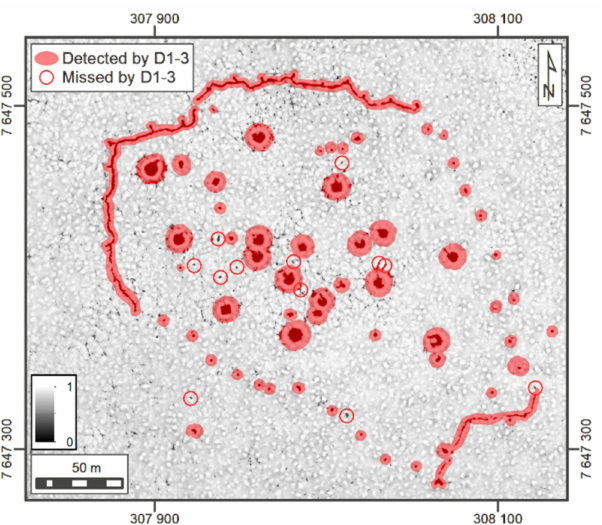
Figure 8. The feature detection results from the CNN detectors D1–3 (highlighted in red) and twelve small (diam. < 1 m) pit features documented in the field but missed by the detectors D1–3 (circled with red) at the German Second World War wilderness outpost at Hirvasvuohppi (see Figure 3).